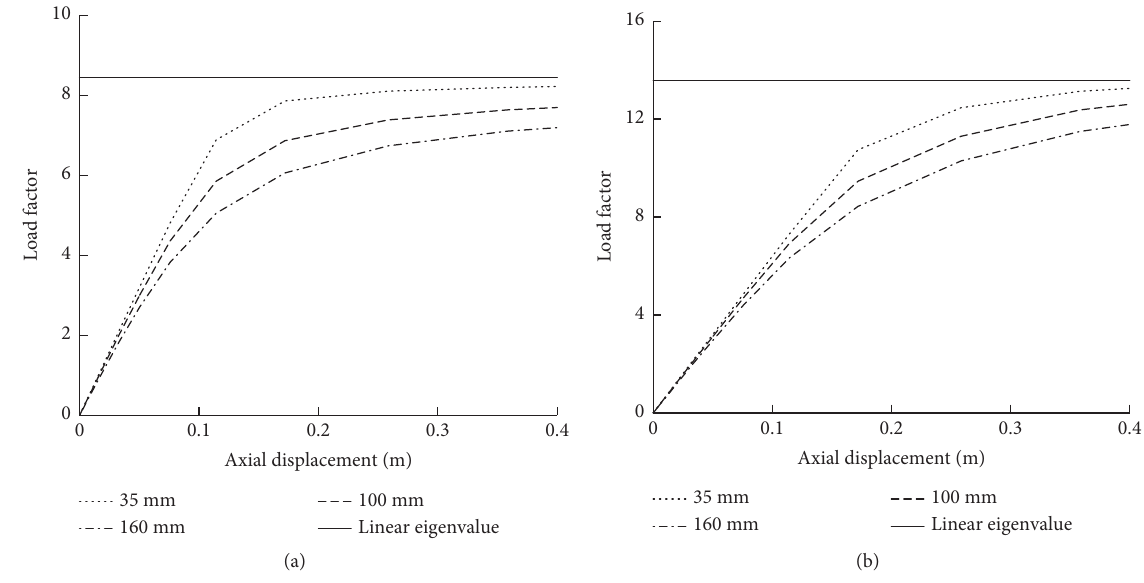
Figure 12: Load factor of the consistent mode imperfection. (a) Case 1. (b) Case 2.